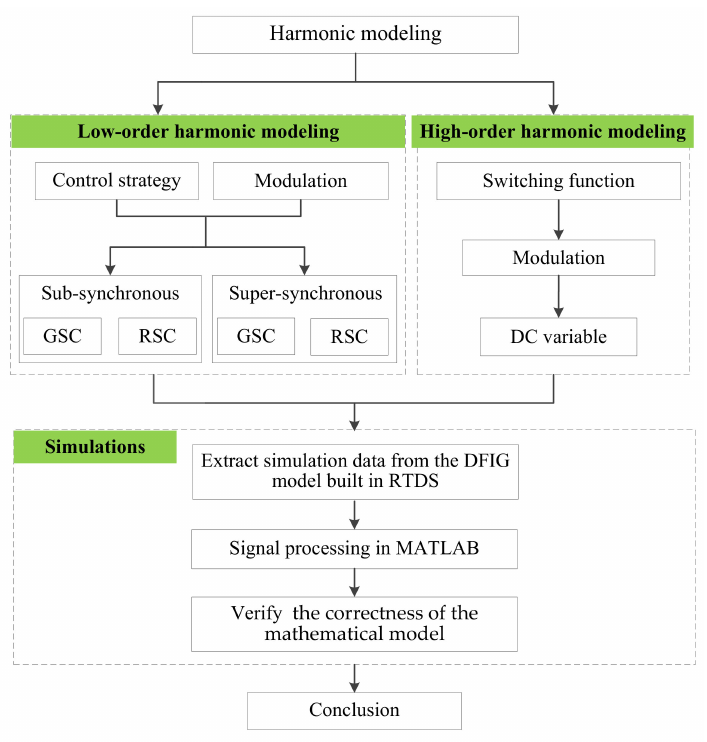
Figure 1. The structure diagram of the article.